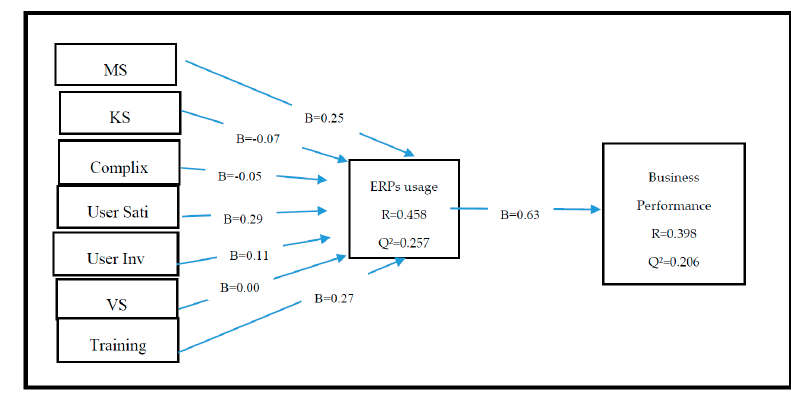
Figure 2. The partial least squares (PLS) model along with path estimates.